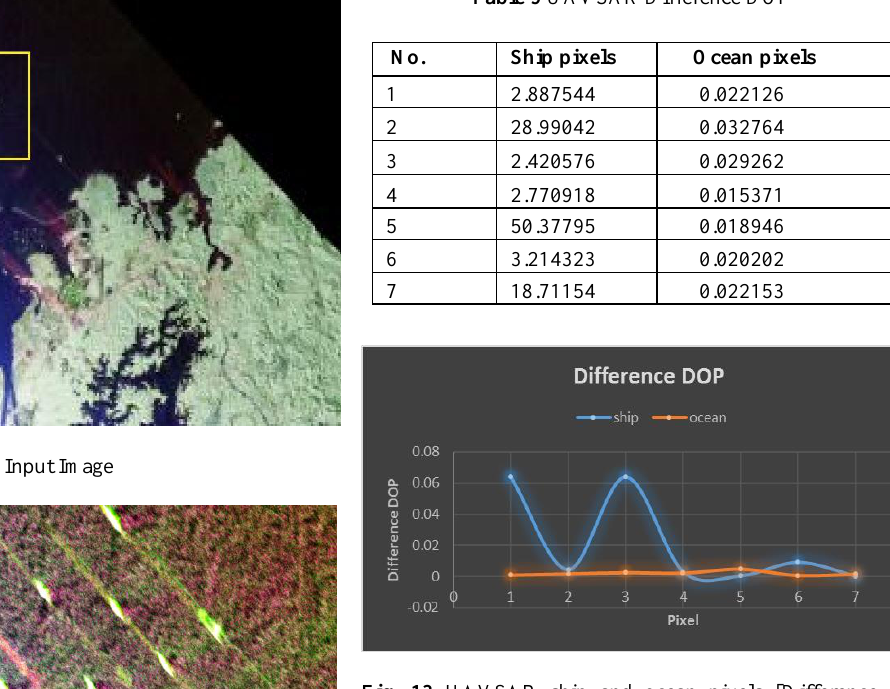
Fig. 13 UAVSAR ship and ocean pixels [Difference DOP] analysis